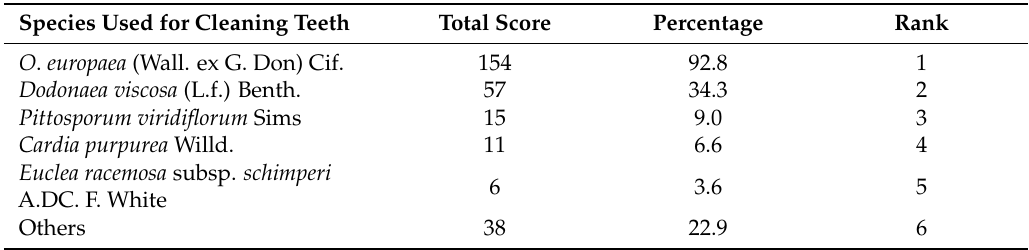
Table 5. Respondents’ total scores and ranking of the six plant species used for cleaning teeth. Species Used for Cleaning Teeth Total Score Percentage Rank